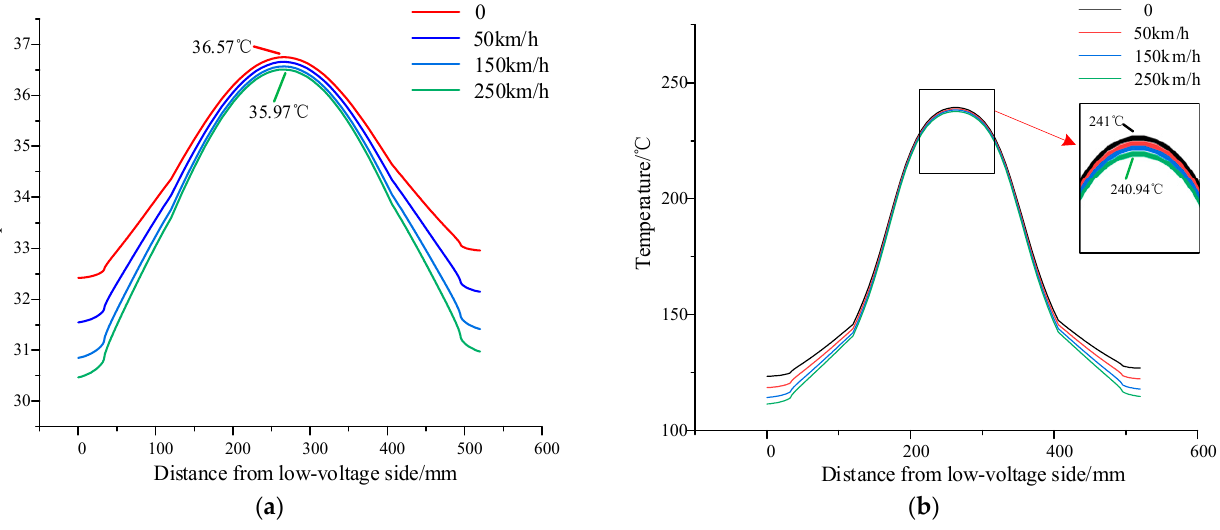
Figure 20. The temperature distribution of the arrester under different air velocities. ( a ) Passing section overvoltage. ( b ) Steep impulse overvoltage.